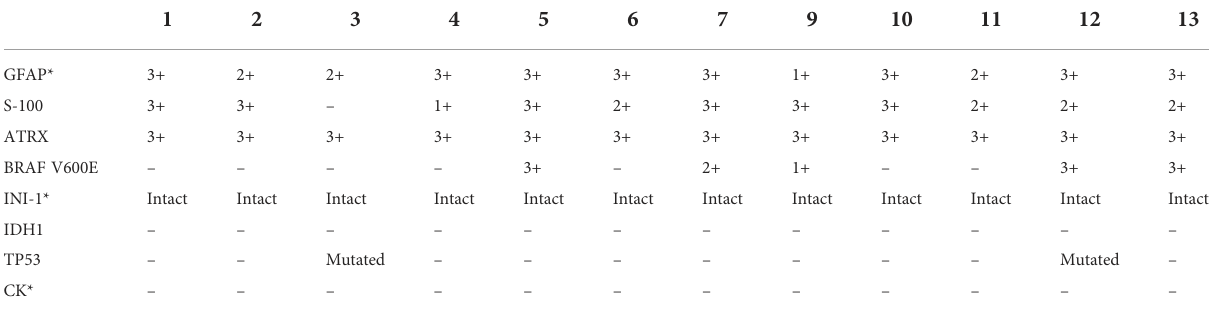
TABLE 2 Immunohistochemistry of 12 eGBM